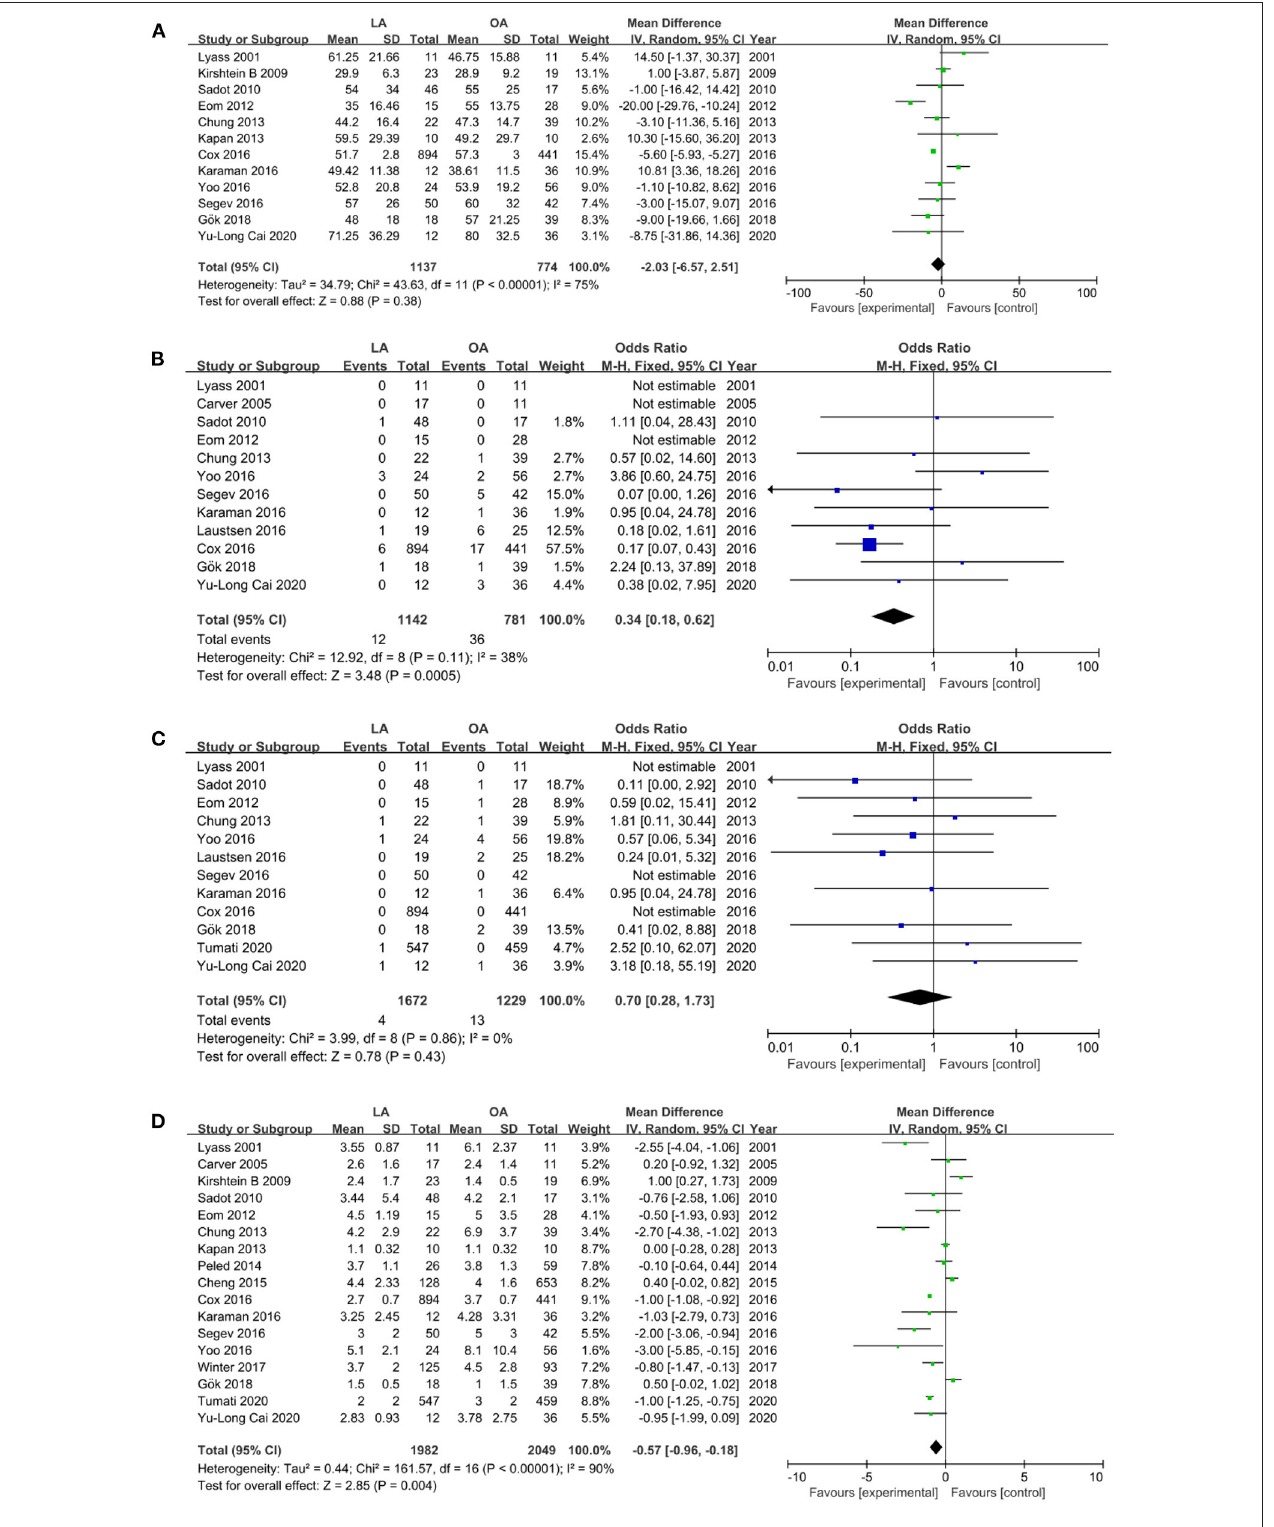
FIGURE 3 | Forest plot of the surgical outcomes comparison of LA vs. OA. (A) Forest plot for operative time (MD − 2.03min, 95% CI − 6.57 to 2.51, P = 0.38); (B) Forest plot for wound infection (OR 0.34, 95% CI 0.18– 0.62, P = 0.0005); (C) Forest plot for abscess (OR 0.70, 95% CI 0.28–1.73, p = 0.43); (D) Forest plot for LOS (MD − 0.57 days, 95% CI − 0.96 to − 0.18, P = 0.004).